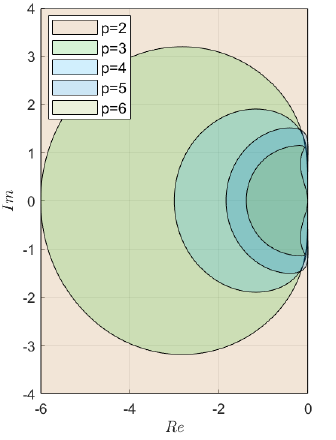
Figure 6. Stability regions of the Adams–Moulton method.